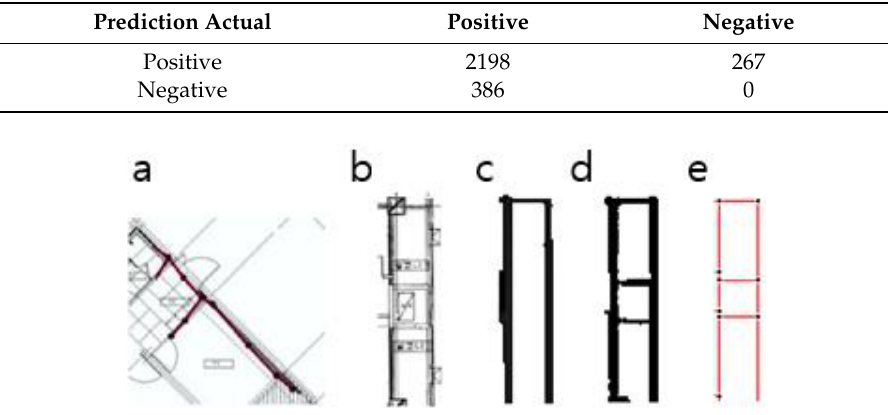
Figure 8. Comparison of ( a ) nodes generated by ground truth with ( b ) extracted nodes.